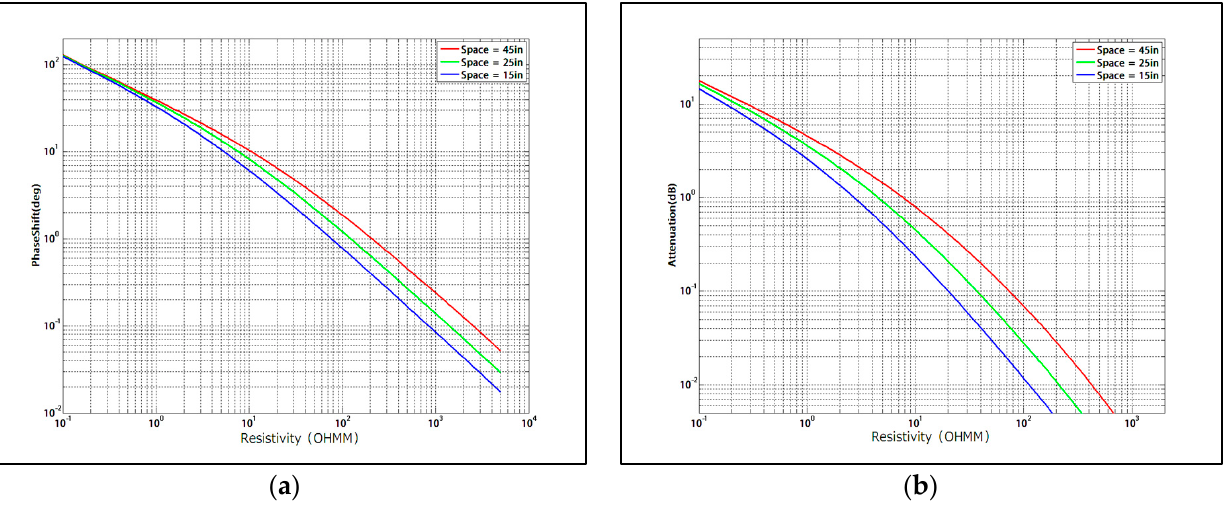
Figure 2. Relationship between induced voltage and formation resistivity under different source spacing: ( a ) Resistivity–phase shift correspondence; ( b ) Resistivity–amplitude attenuation correspondence.